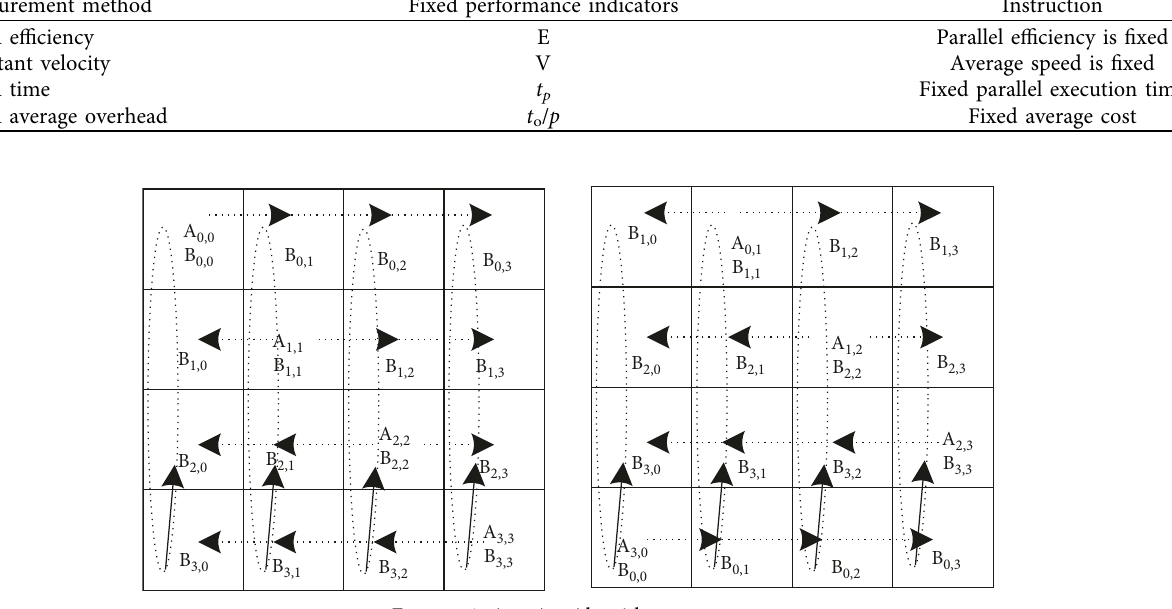
Figure 6: A 00 , A 01 Algorithm process.